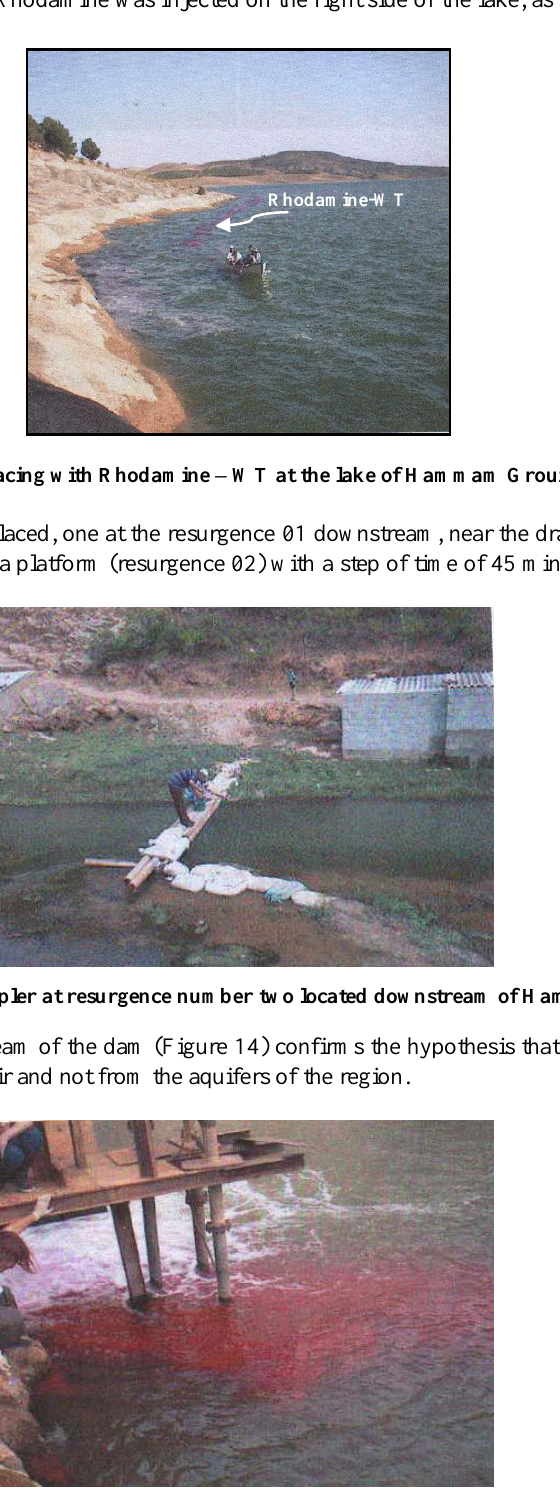
Figure 14. Rhodamine response downstream from the dike of Hammam Grouz